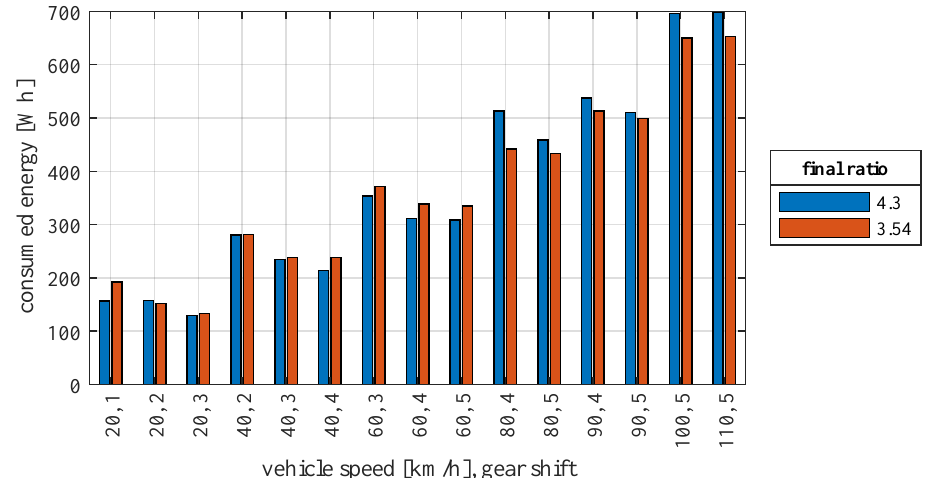
Figure 13. Energy consumed at a constant speed.